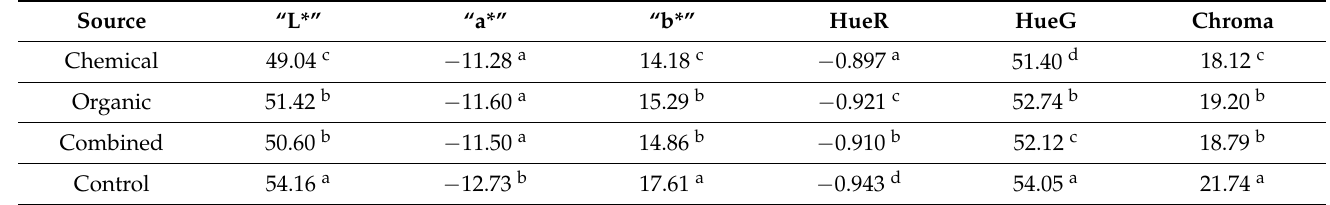
Table 10. L*, a*, b*, hue, and chroma in tuberose leaves from plants grown with different fertilizer